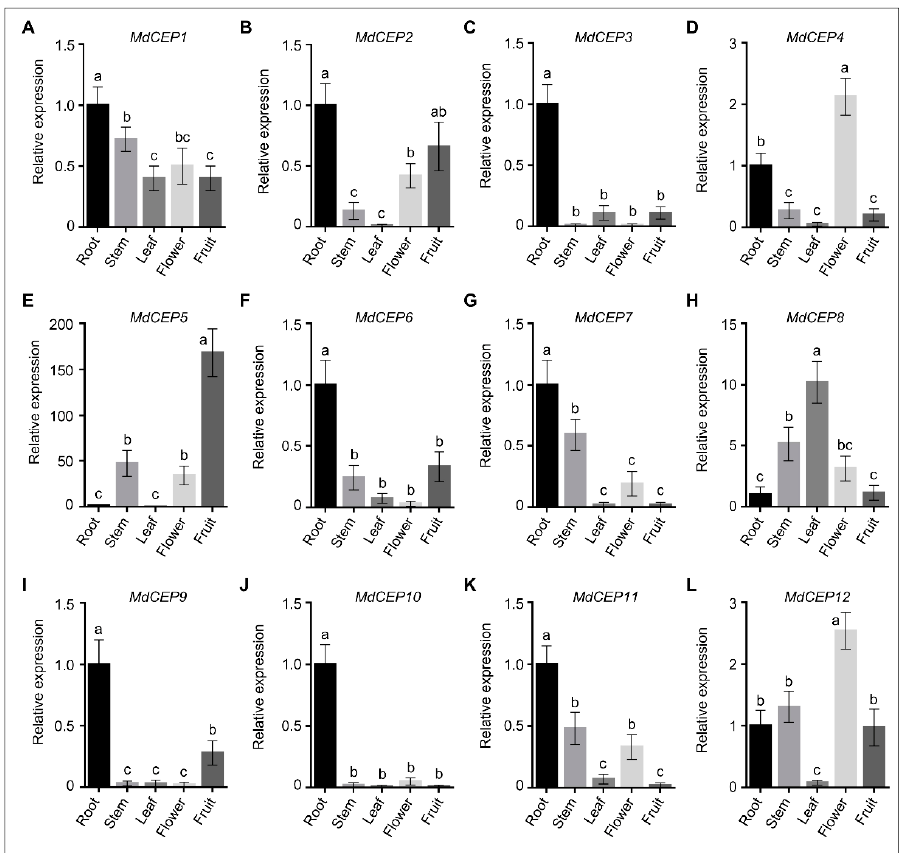
Figure 3. The tissue expression pattern of MdCEPs in apple. The expression levels of MdCEP1